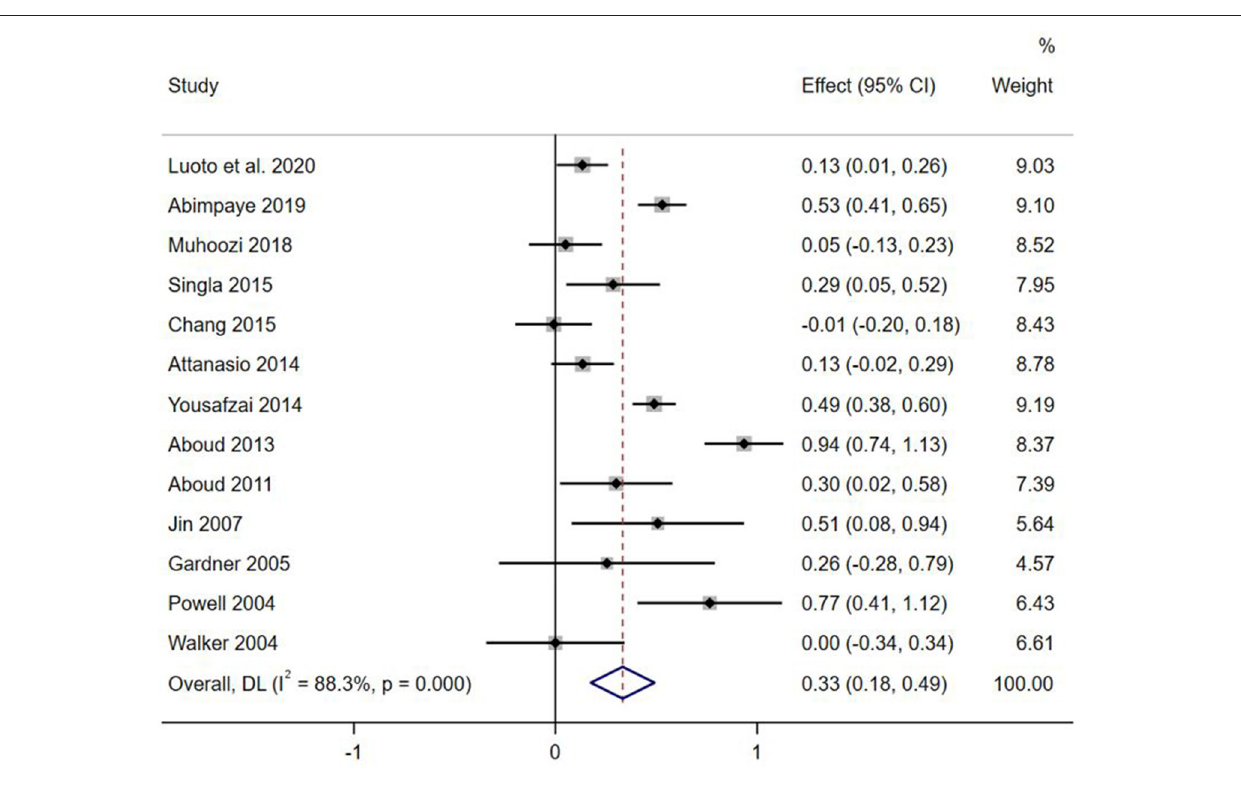
FIGURE 3 | Effect sizes on Language